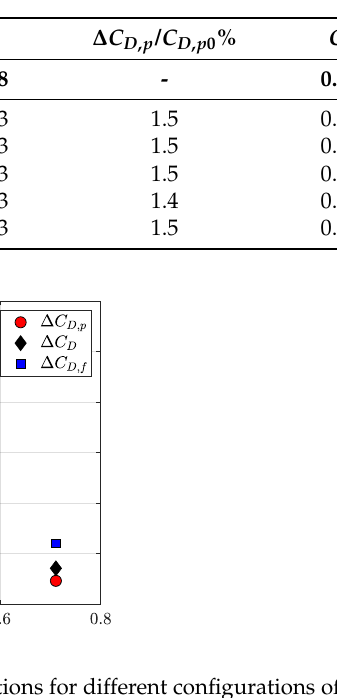
Table 3. Drag breakdown for the UAV in cruise condition, for different configurations of riblets coverage, and percentage changes with the clean case.